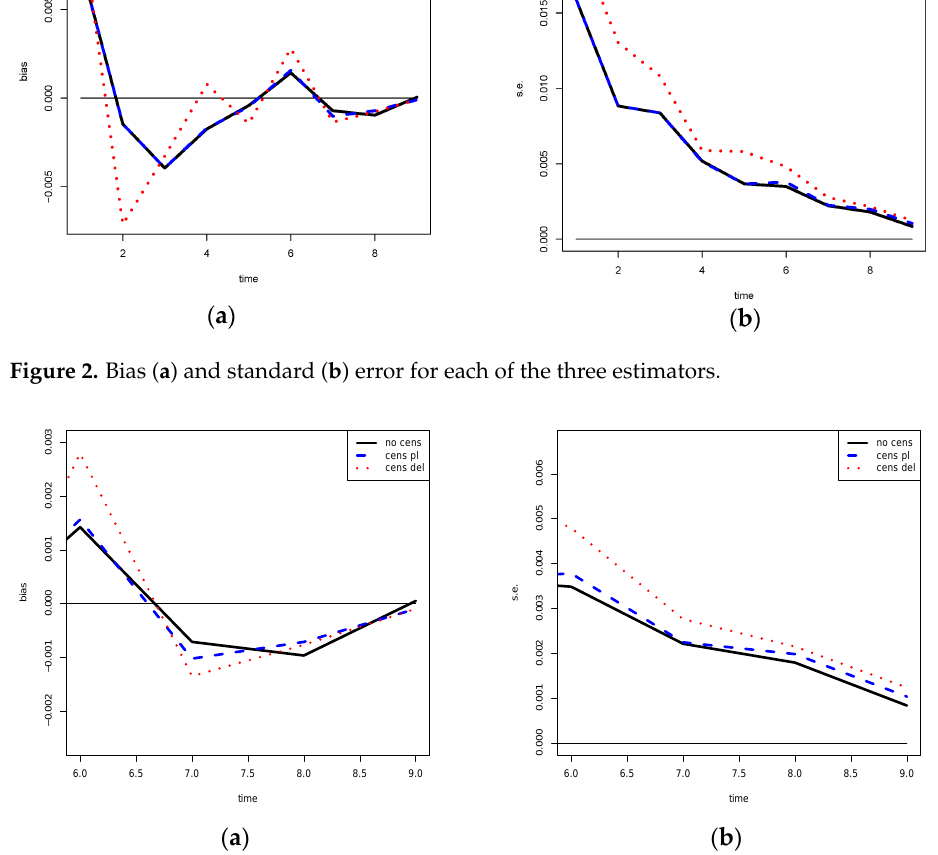
Figure 3. Zoom of the tail of the plot in Figure 2. ( a ) Bias and ( b ) standard. On the same data, we also evaluated the performance of the three spline estimators proposed in Section 2.3 (colored dashed lines) in comparison with the “cens pl” estimator (black solid line). The results are depicted in Figures 4 and 5. Figure 4 depicts the results in terms of bias and Figure 5 depicts the results in terms of standard